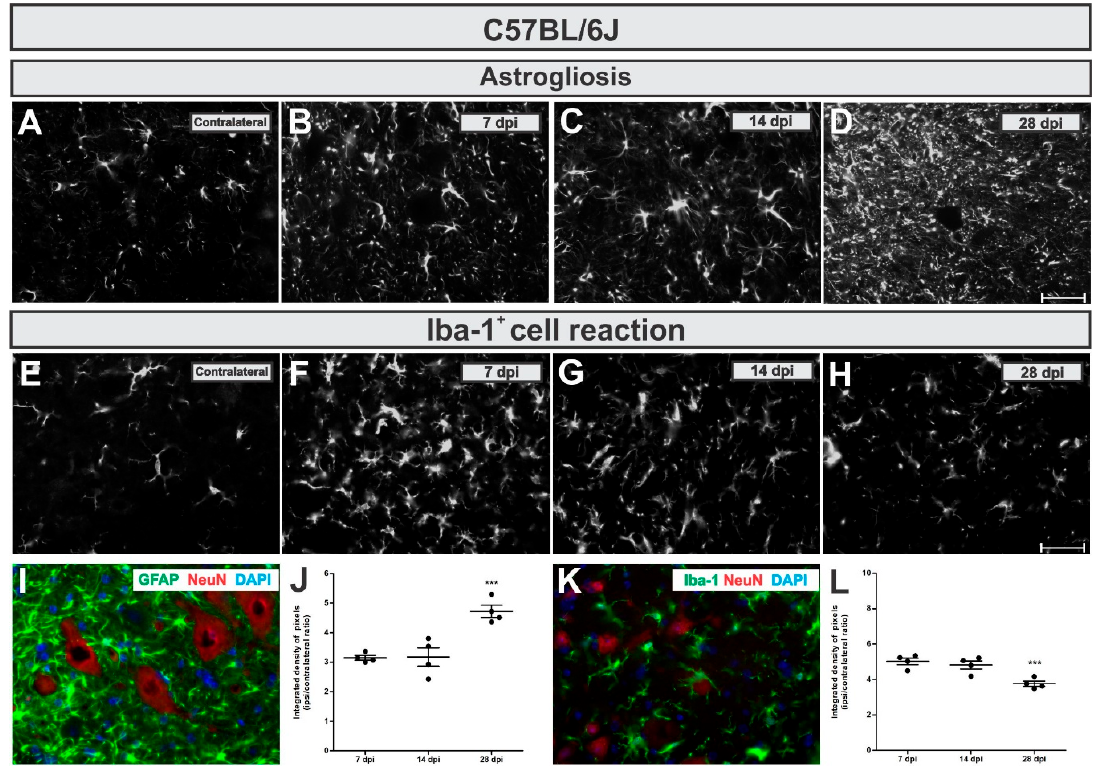
Figure 4. Time-course of astrogliosis ( A to D and I ) and Iba-1 + cell reaction ( E to H and L ) in the lumbar spinal cord contralateral side and 7, 14 and 28 dpi post ventral root injury in WT mice. Note that astrogliosis increases over time. Contrarily, the Iba-1 + cell reaction is more intense in the acute phase after injury. I and K illustrate the glial reaction in the ipsilateral side nearby axotomized motoneuron-like cells, positive to NeuN (in red). ( J and L ) show the comparative quantification among time points post injury (ipsi / contralateral ratio); p < 0.001 (***). Scale bar = 50 µ m.